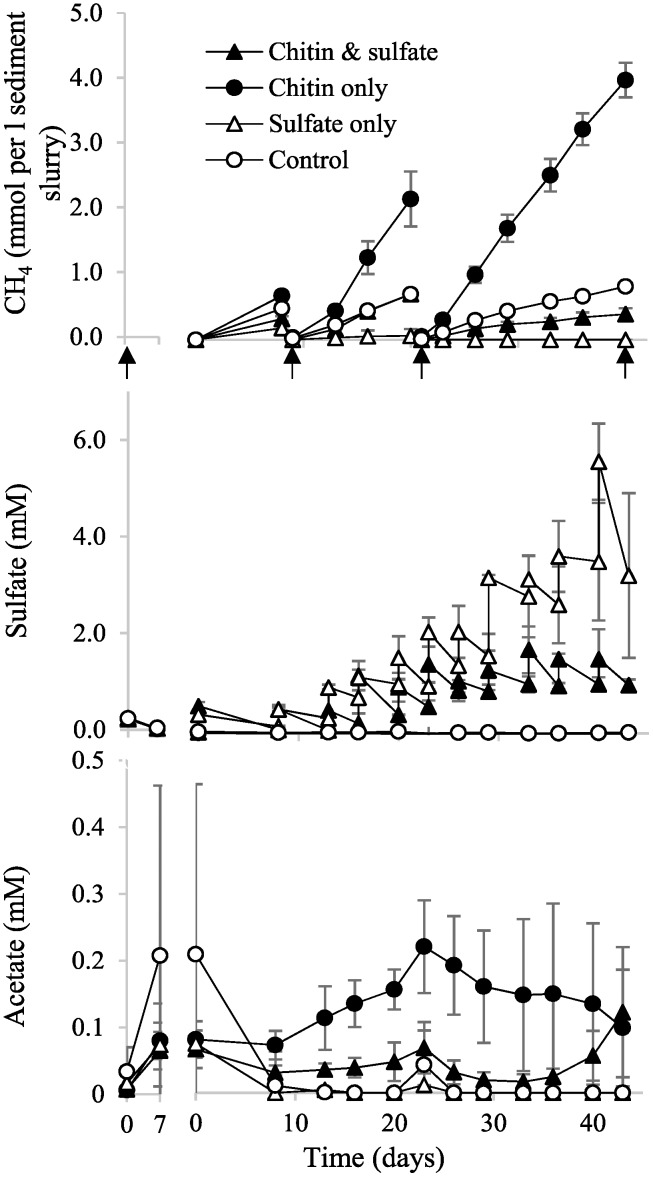
Time course of sulfate turnover and formation of metabolic end products in incubated sediment microcosms. The gap illustrates the shift from pre-incubation to the chitin and/or first sulfate amendment. Sulfate was always measured twice: before and after supplementation. Opening of microcosms under anoxic conditions for sediment sampling is indicated by black arrows. The mean and one standard deviation are shown, n = 3. Some error bars are smaller than the symbol size.